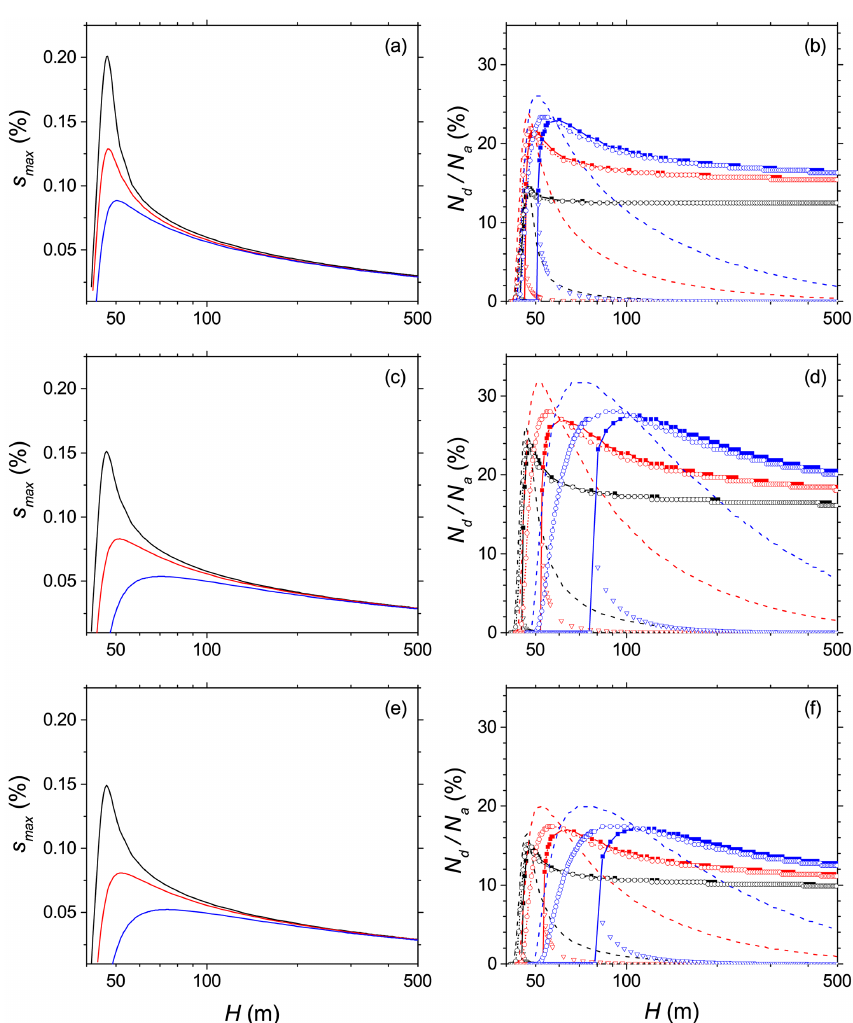
Figure 8. Supersaturation (left) and aerosol activated fraction (right) as a function of cloud height for an internally mixed population with κ p = 0 . 06 (black), κ p = 0 . 25 (red) and κ p = 0 . 60 (blue), and W = 0 . 5ms − 1 . The cloud droplet concentration was estimated as either N d,eq (dashed line), N d , neq (solid line, open circles) or N d,neq (solid line, close squares). The fraction of the population not strictly activated in simp N d,neq is indicated (open downward-facing triangles). Plots on panels (a, b) , (c, d) and (e, f) correspond to MP 5 , 1 , MP 1 , 5 and HP 5 , 5 case studies,